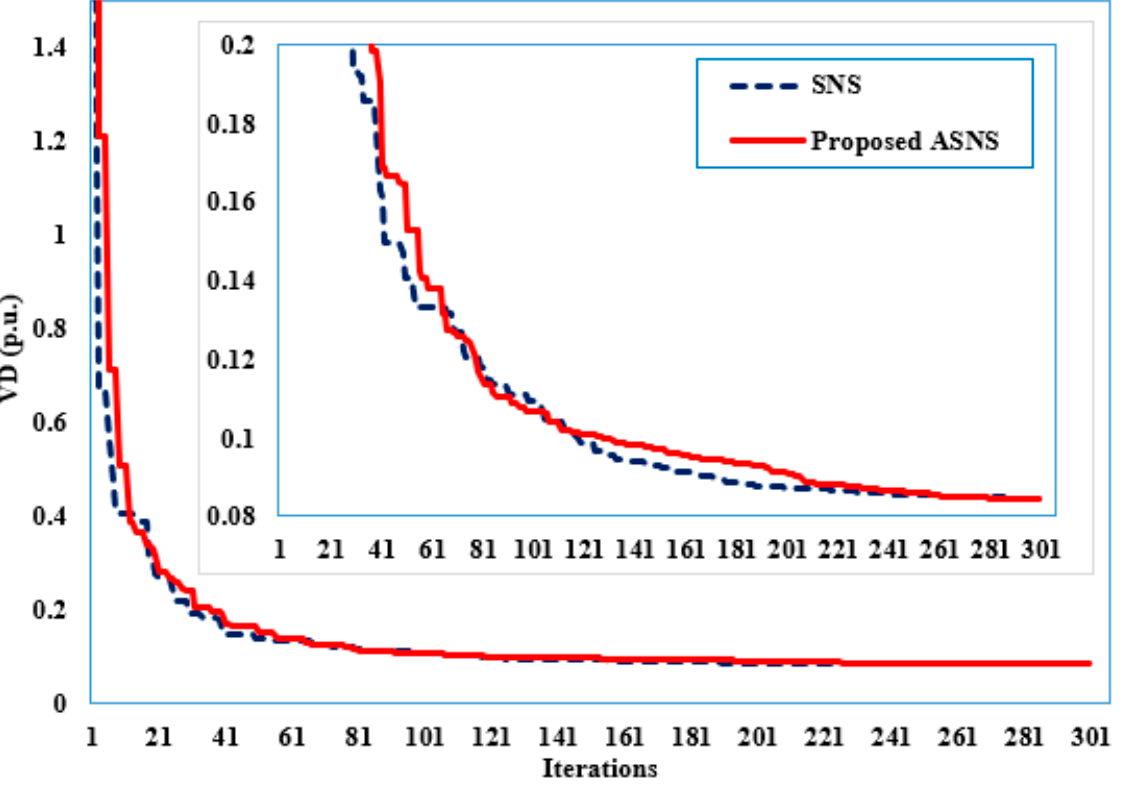
Figure 5. Convergence features of the proposed ASNS and SNS for Case 2 of the IEEE 30-bus grid.